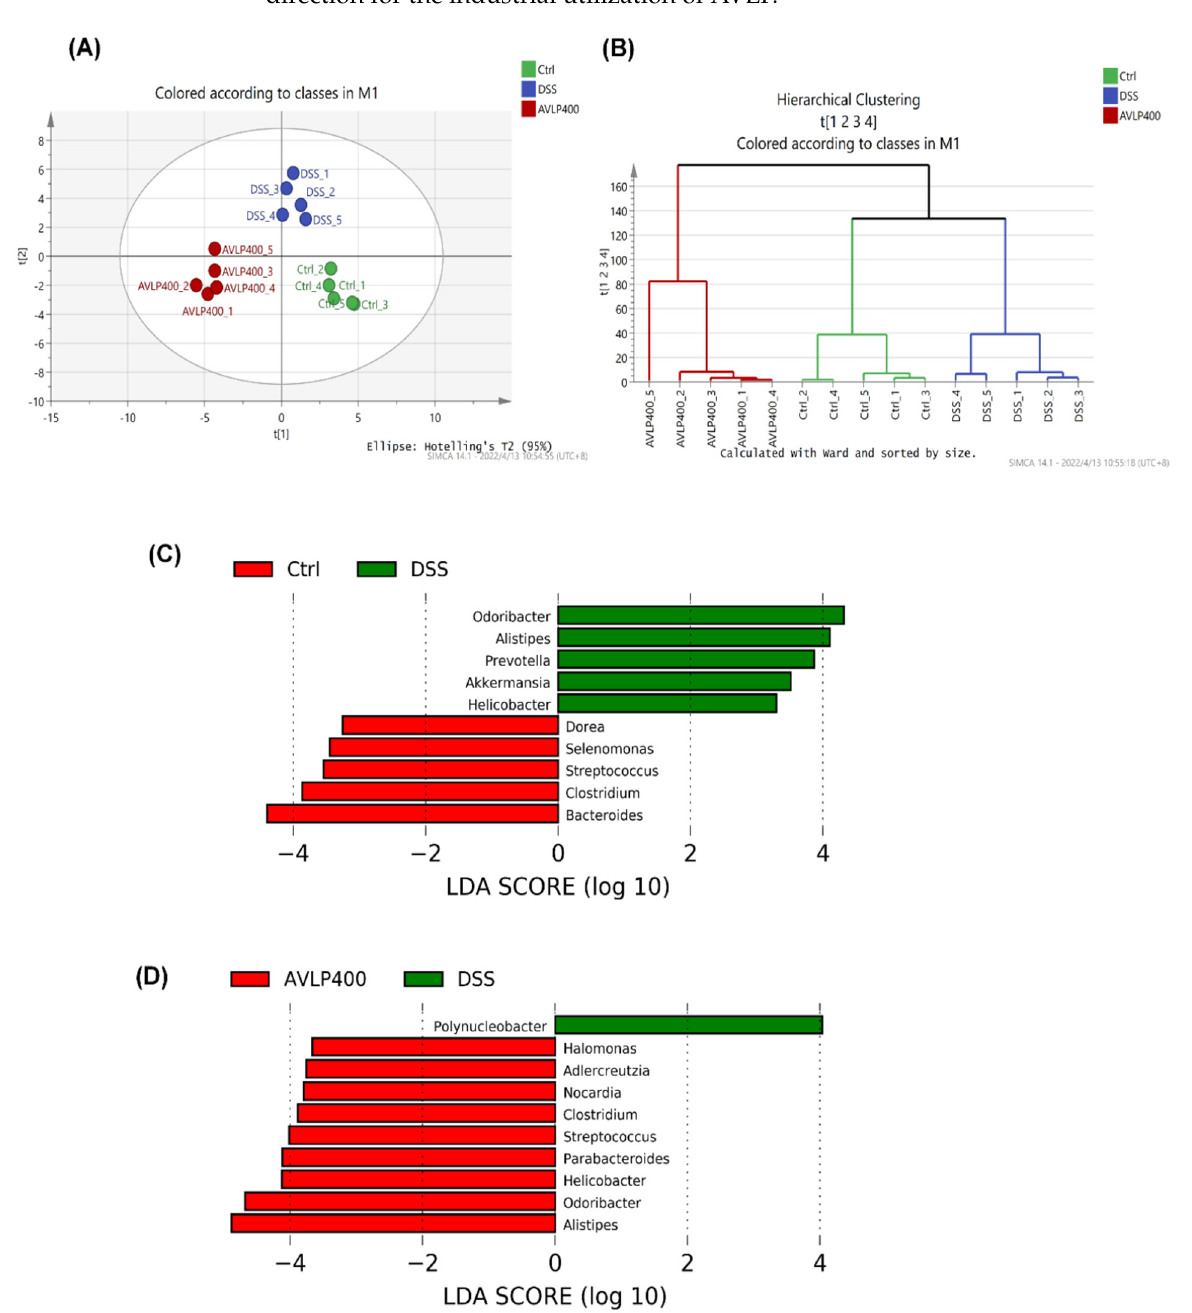
Figure 5. Effect of AVLP on gut flora in colitis mice. ( A ) Partial least squares discrimination analysis. ( B ) Hierarchical clustering tree analysis. ( C ) LEfSe comparison between the Ctrl and DSS groups. ( D ) LEfSe comparison between the DSS and AVLP400 groups.